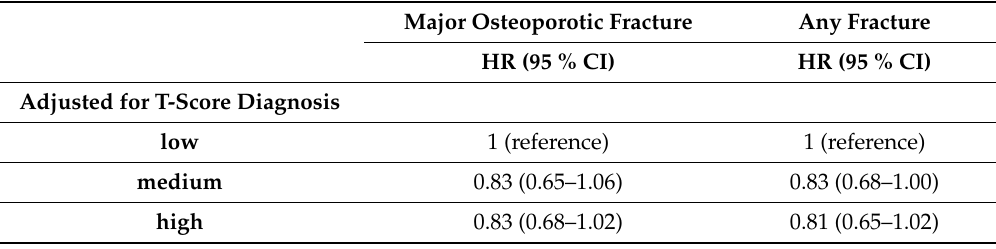
Table A3. Hazard Ratios (HR) with 95% Confidence Interval (CI) for Outcomes of Incidence Fracture According to PGS Group, adjusted for T-score diagnosis: Results from Cox Proportional Hazard Model, Individuals with Previous Fractures were